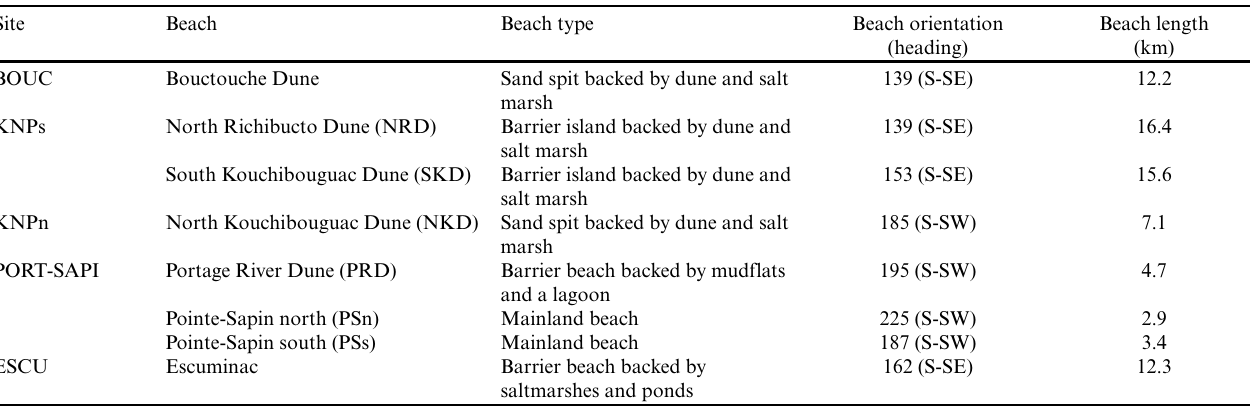
Table 1 . Type, orientation, and length of beaches at study sites in southeastern New Brunswick,